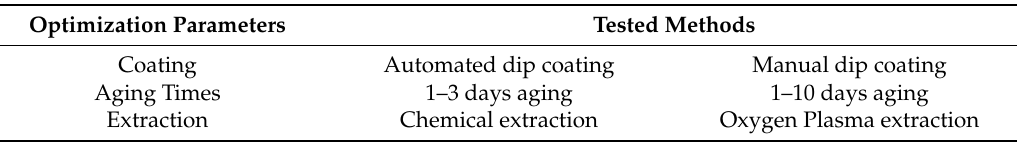
Table 1. Summary of optimization parameters tested in order to maximize the performance of the WGM optical resonators.